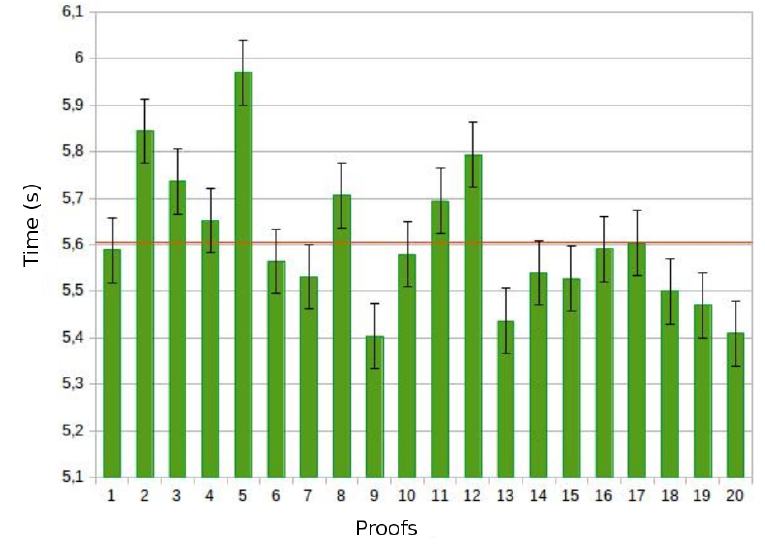
Figure 10. saveAsTextFile action for 5 GB file. 20 proofs average and confidence interval equal to